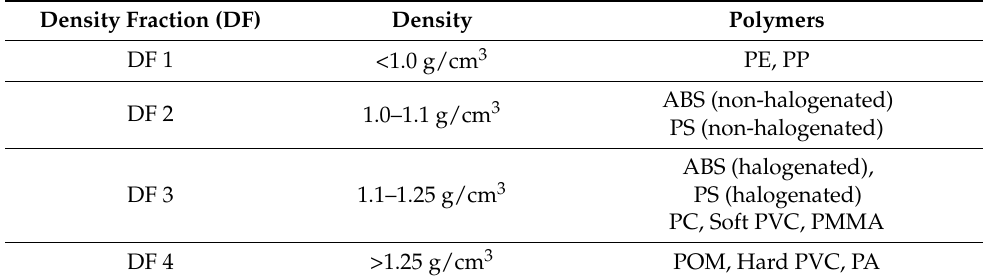
Table 2. Density fractions and plastic